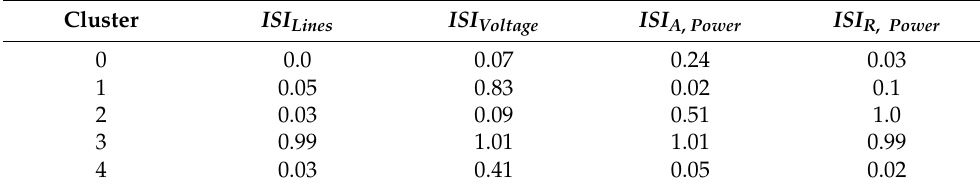
Table 2. Cluster centroids using